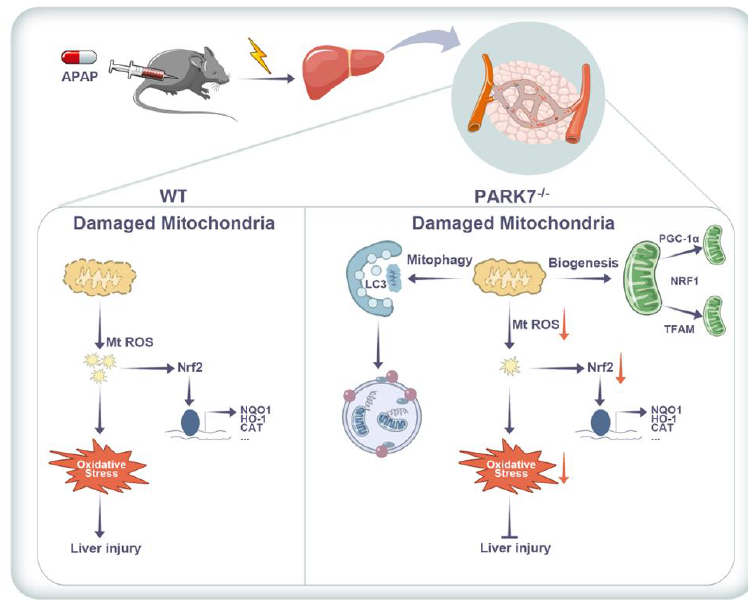
Figure 7. Scheme of this study.